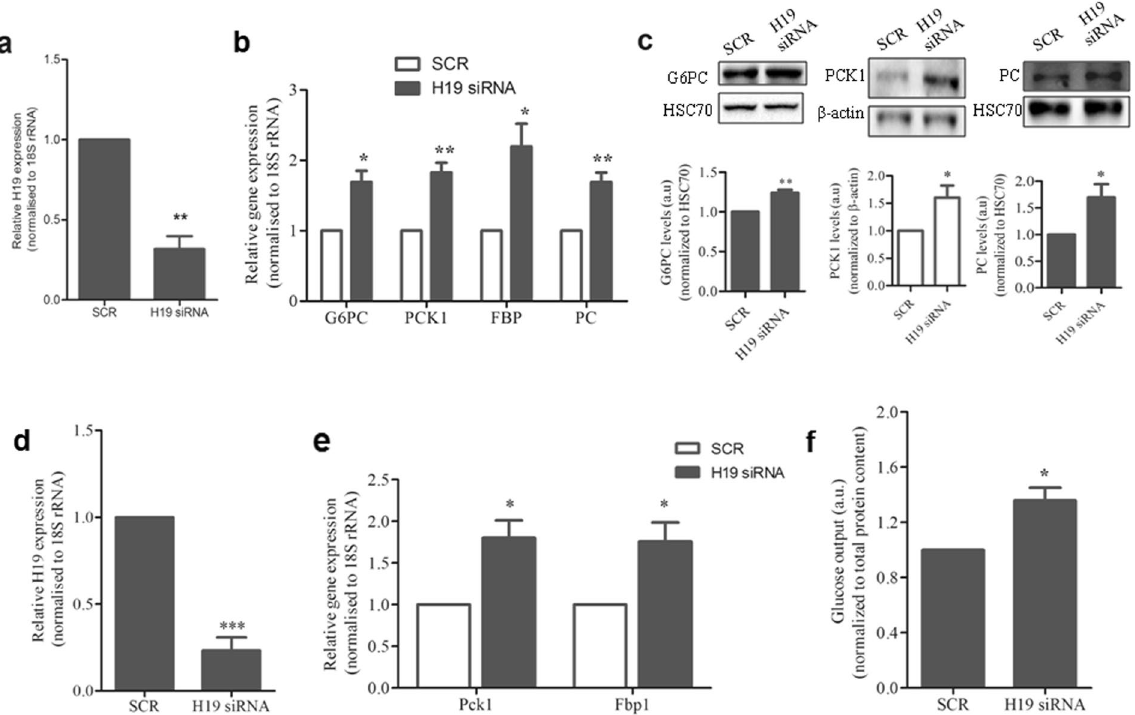
Figure 5. H19 inhibition elevates gluconeogenic gene expression. ( a ) HepG2 cells were reverse transfected with H19 siRNA (5 nM) and control cells were transfected with the scramble (SCR). After 48 h of incubation, RNA was isolated and assessed for the transcript level of H19 by qRT-PCR using specific primers. ( b ) RNA from HepG2 cells transfected with either H19 siRNA (5 nM) or the scramble was assessed for the expression of gluconeogenic genes (G6PC, PCK1, PC and FBP) by qRT-PCR using specific primers listed in Supplementary Table S3. ( c ) HepG2 cells were reverse transfected as in ( a ) and lysed after 48 h. 30 µ g protein was probed for the detection of G6PC, PC and PCK1 by western blot analysis. HSC70 and β -actin were used as loading controls. Full length blots are presented in Supplementary Information (Supplementary Fig. S2). ( d ) Primary mouse hepatocytes were transfected with either the scramble or H19 siRNA (5 nM). After 48 h of incubation, RNA was isolated and H19 transcript levels were assessed by qRT-PCR using specific primers. ( e ) RNA from mouse primary hepatocytes which were transfected with either the scramble or H19 siRNA (5 nM, 48 h) was assessed for the expression of gluconeogenic genes (Pck1, Fbp1) by qRT-PCR using specific primers as listed in Supplementary Table S3. 18S rRNA was used as a normalization control for all the genes. ( f ) HepG2 cells were reverse transfected as in ( a ) and on termination of incubation, glucose output in the media was measured as described in the “Methods” section. Total protein content from whole cell lysates was used for normalization. Each experiment was done at least thrice and data is presented as mean ± s.e.m. * P < 0.05, ** P < 0.01, *** P < 0.001 as compared to scramble transfected cells